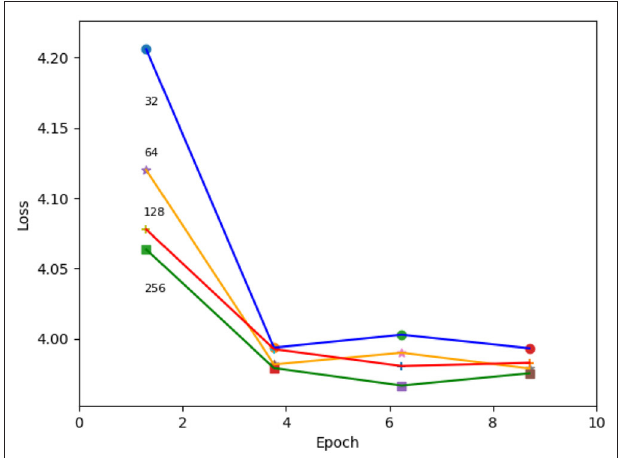
FIGURE 14 | Loss as a function of training epoch for varying depths of the neural network’s convolutional layers. The depth of the convolutional layers used for each training is indicated at the start of the respective line.